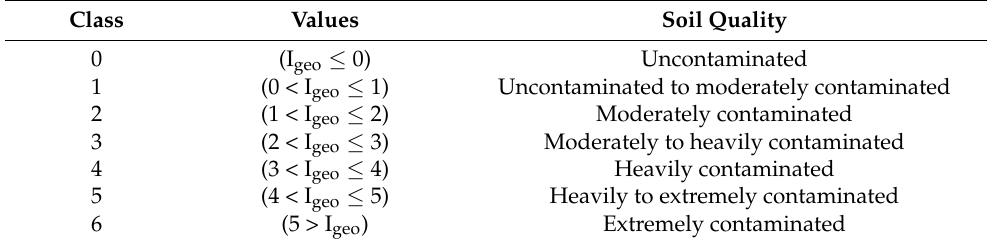
Table 1. Assessment of values, classes, and quality description of the geoaccumulation